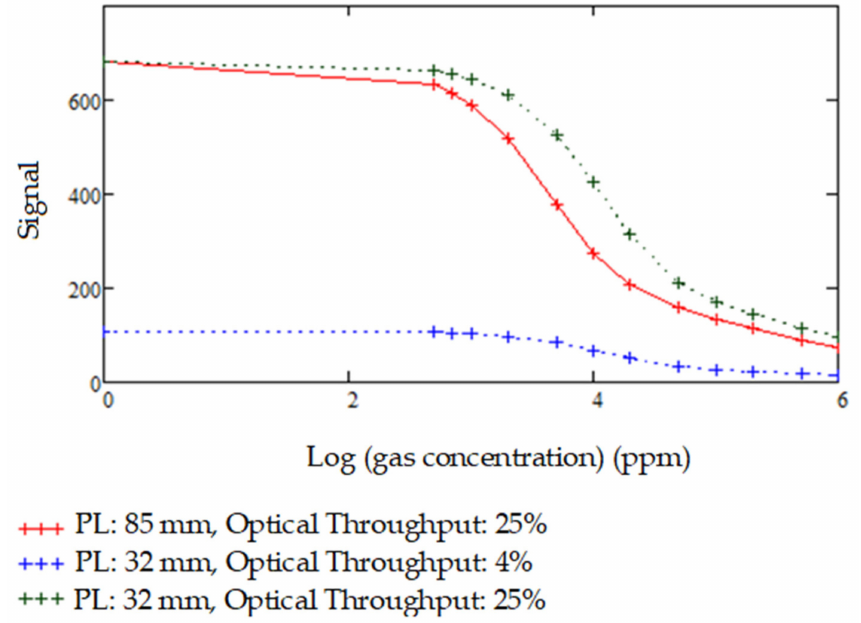
Figure 19. Detectable signal modelled for di ff erent path length–optical throughput combinations for CO2 gas concentrations upto 1,000,000